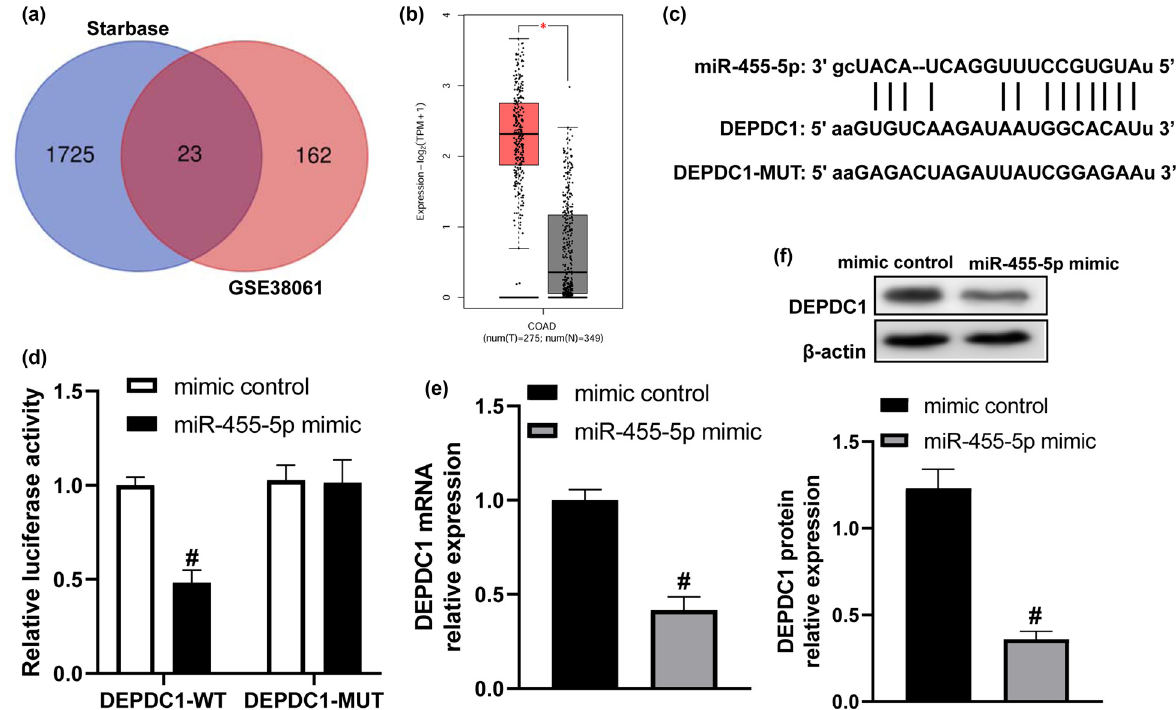
Figure 4: DEPDC1 is a target of miR - 455 - 5p in CRC cells. ( a ) Venn diagram of speci fi c genes between potential miR - 455 - 5p target genes from Starbase and di ff erentially expressed genes from the GEO dataset GSE38061. ( b ) GEPIA2 software assay for DEPDC1 expression in colon adenocarcinoma ( COAD ) tissues and normal samples. ( c ) The binding sites between miR - 455 - 5p and DEPDC1. ( d ) HT - 29 cells were co - transfected with DEPDC1 - WT/DEPDC1 - MUT luciferase reporter vectors and miR - 455 - 5p mimic/mimic control for 48 h, and the luciferase activity was detected. ( e and f ) miR - 455 - 5p mimic signi fi cantly decreased the DEPDC1 mRNA and protein levels in HT - 29 cells. * P < 0.05 vs normal tissues, # P < 0.05 vs the mimic control